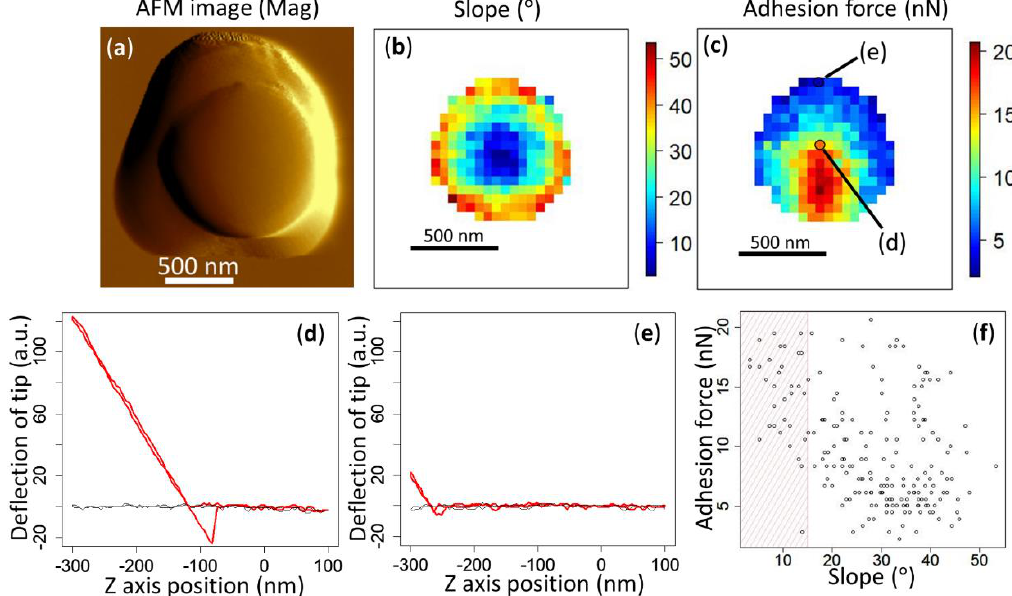
Figure 2. Atomic force microscopy (AFM) mag image ( a ), slope mapping ( b ), and adhesion force mapping ( c ) obtained from the same 1 µ m PSL particle. Representative force–distance curves are shown for the point at which the tip is properly in contact with the surface with su ffi cient stroke (loading force), at the proper angle ( d ) and for the point further towards the edge where the tip is barely touching the surface at a steep angle ( e ). The black lines in panels ( d ) and ( e ) show the baseline in which the tip did not touch the particle or substrate. A plot of the relationship between the slope and the adhesion force is shown in panel ( f ). The plots in the shaded area are considered to represent the adhesion force of the particle. Corresponding AFM height and phase images can be found in Figure S2 in the Supplementary Information.